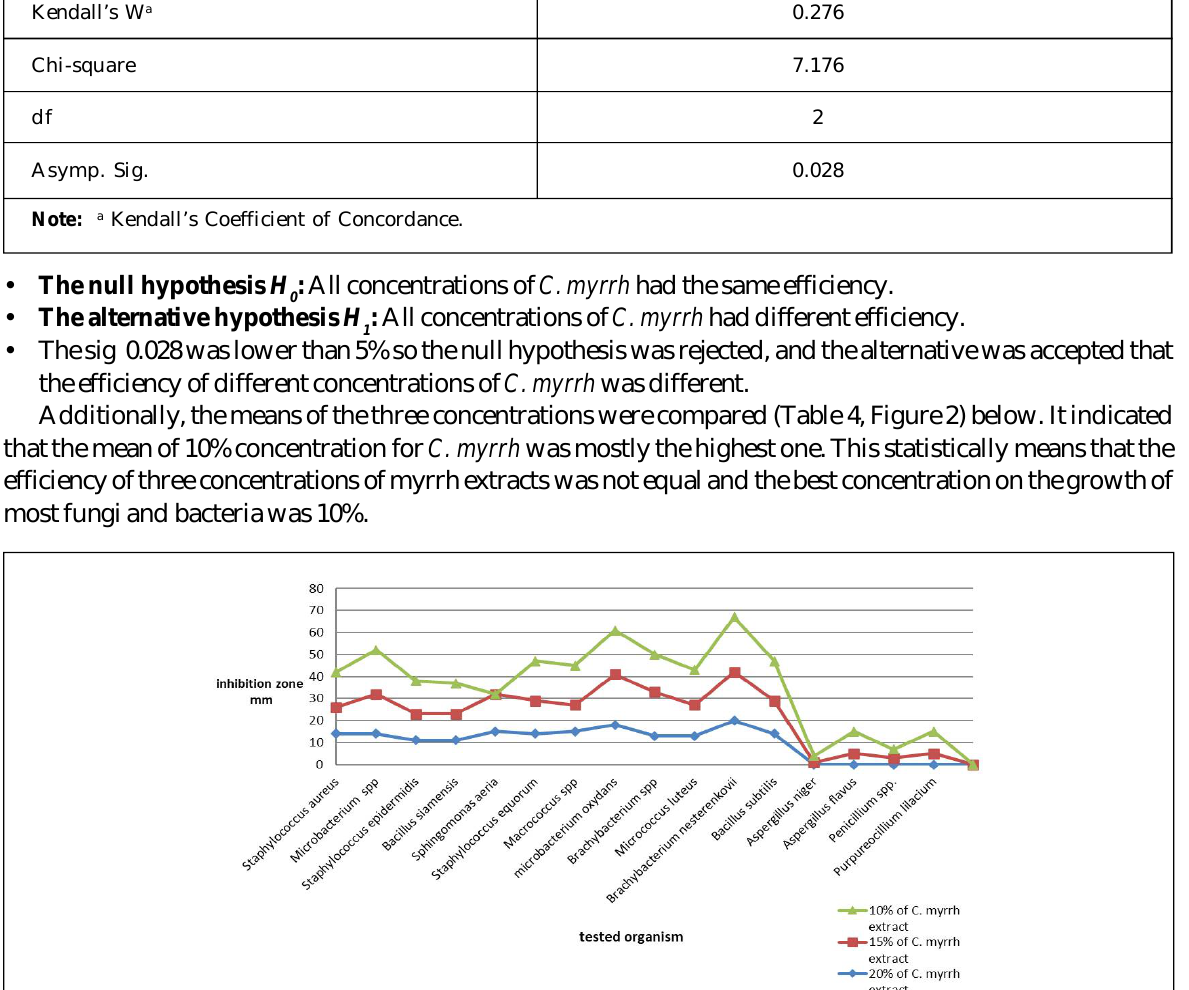
Table 5: Test statistic